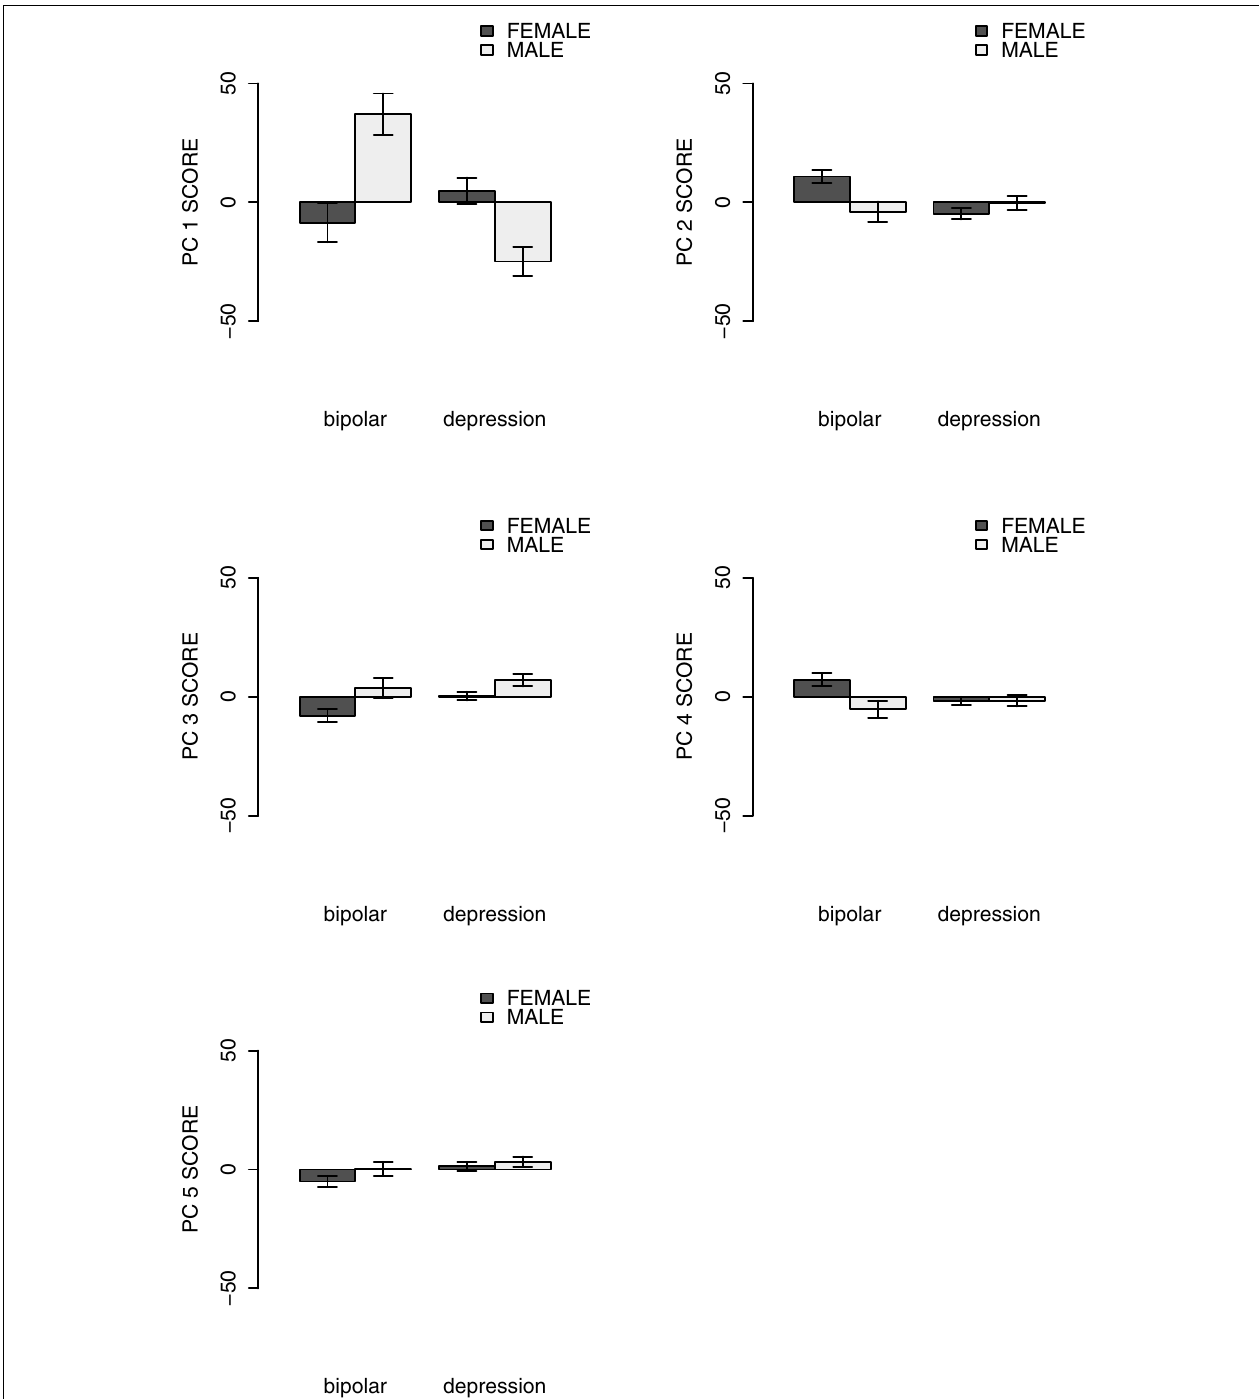
FIGURE 3 | Mean PC scores of major depression and bipolar disorder.